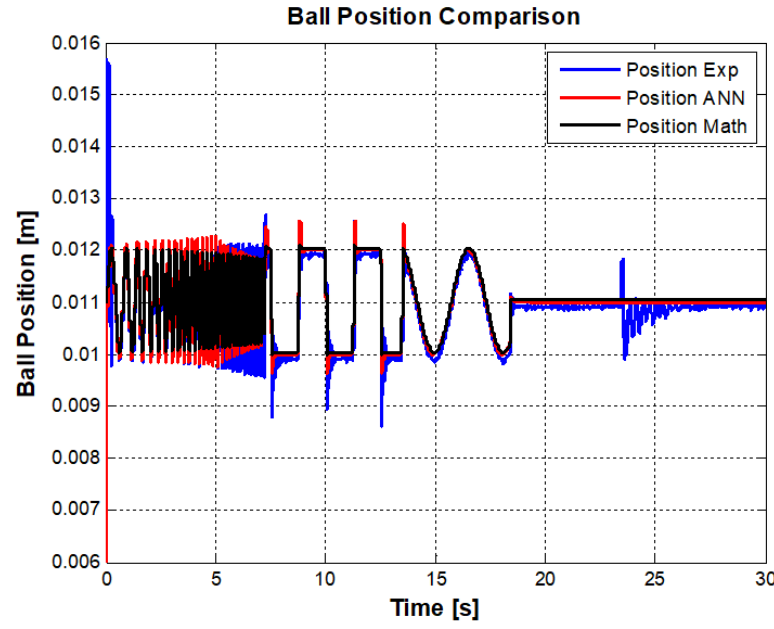
Figure 8. Ball position comparison among real model, ANN model and Mathematical